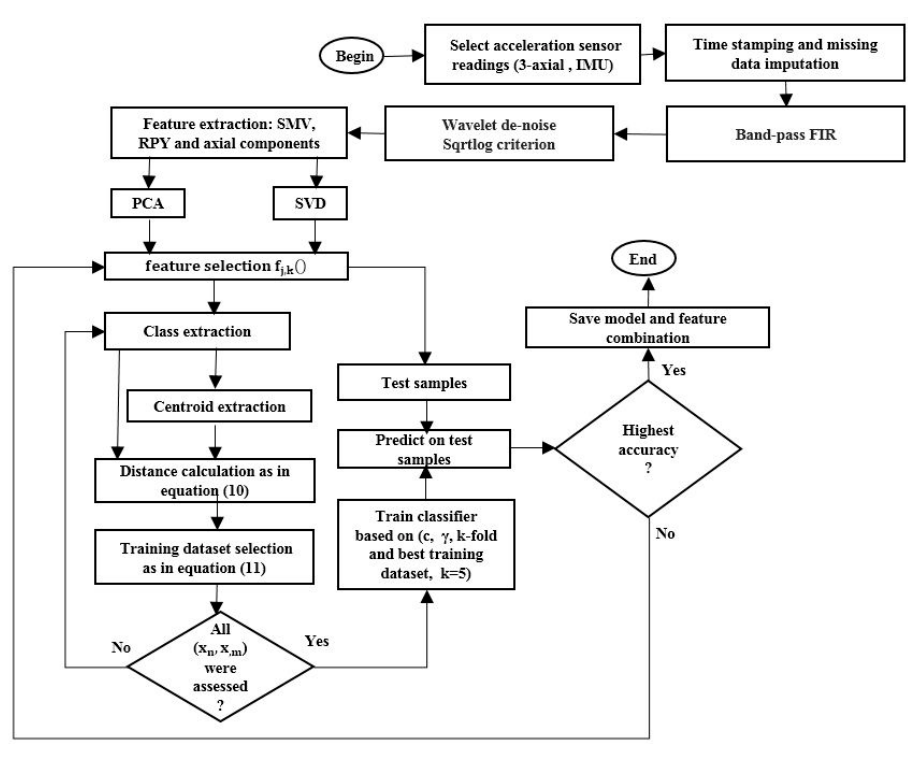
Figure 2. Iterative architecture for multiclass classification. Figure 2.